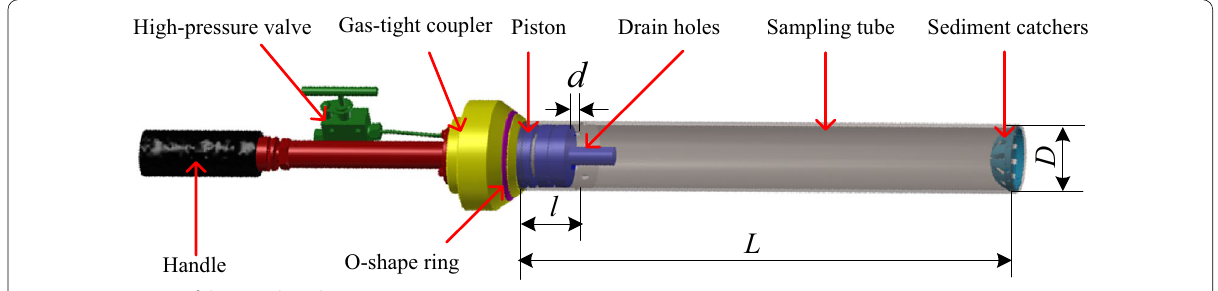
Figure 1 Structure of the sampling